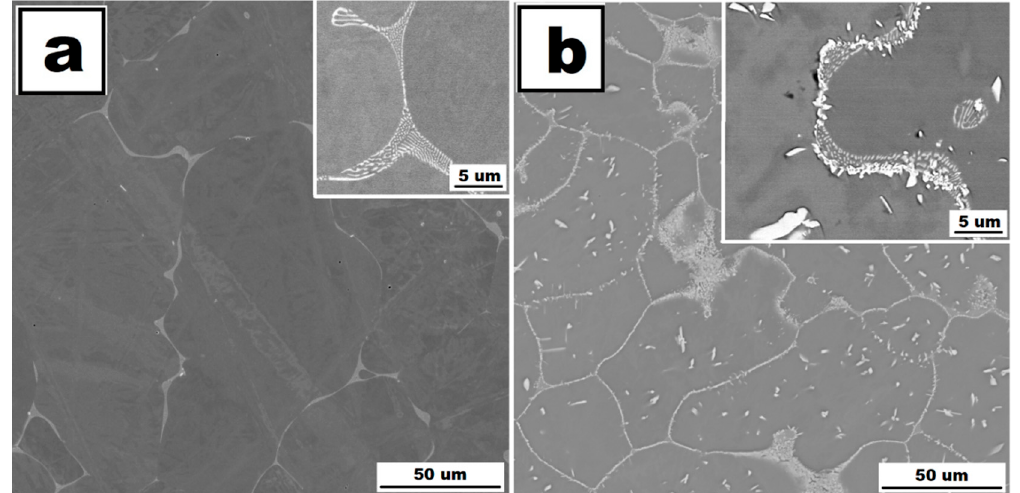
Figure 4. The structure of Fe28Al5Si2Mo alloy in as-cast state ( a ) and the structure of Fe28Al5Si2Mo alloy after annealing at 800 °C for 100 h ( b )—(SEM, BSE, 20 kV). In detail ( b ): dark grey—Fe 3 Al matrix, light grey particles—eutectics, white particles—Mo-based silicides.